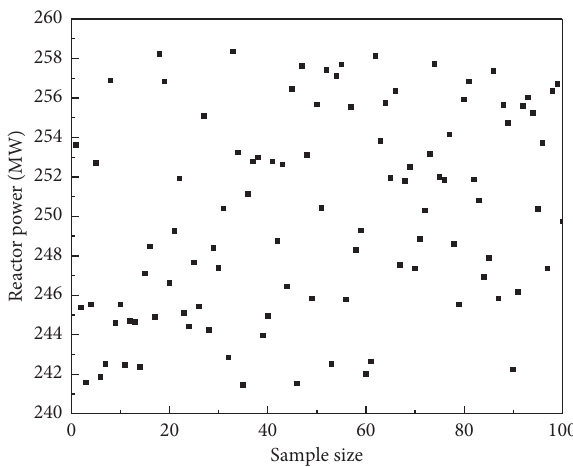
Figure 8: Sampled values of the reactor power (MW) for the 100 LHS-SVDC normal set.